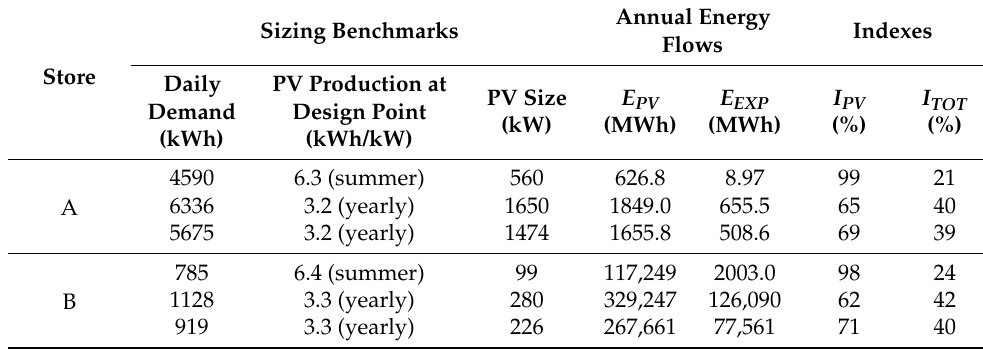
Table 6. PV production data for one year of operation for different self-consumption levels.